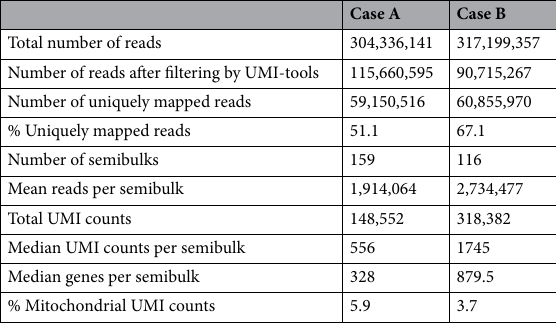
Table 3. Summary of sbRNA-seq of breast cancer